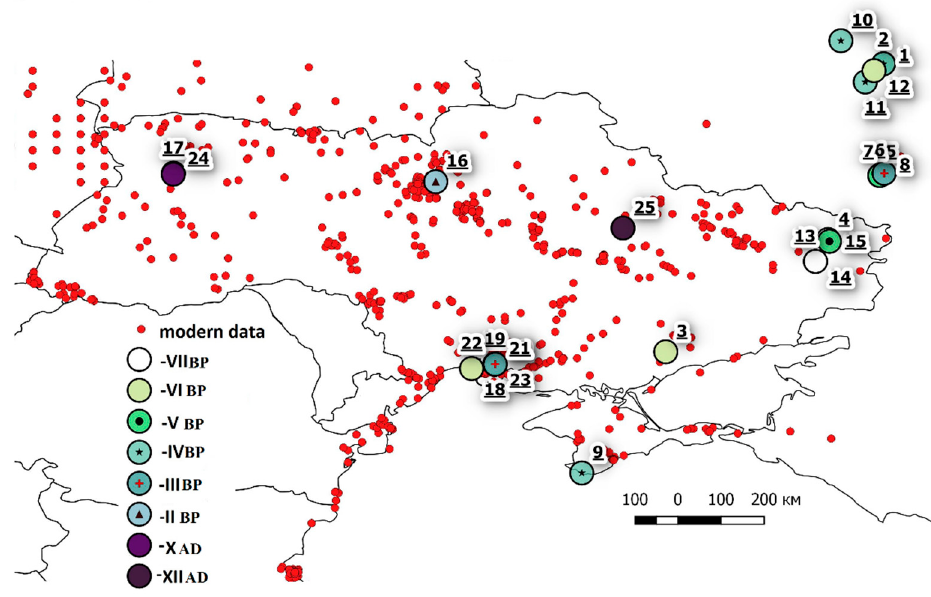
Figure 1. Map of subfossil records (from VII BP to XII AD: Ukraine, Russia) of E. orbicularis (Table 1).